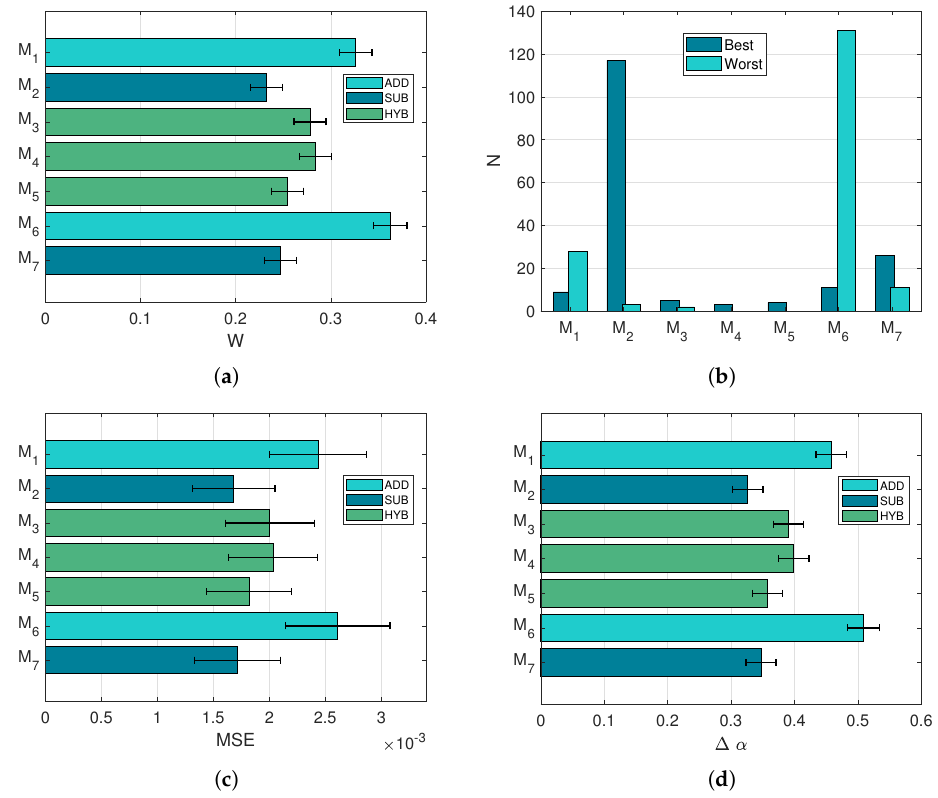
Figure 7. Performances in the prediction task. All error bars refer to 95% confidence intervals. ( a ): Mean w score. ( b ): Number of times each model has been selected as best or worst in terms of w score. ( c ): Average MSE. ( d ): Mean concentration error ∆ α .